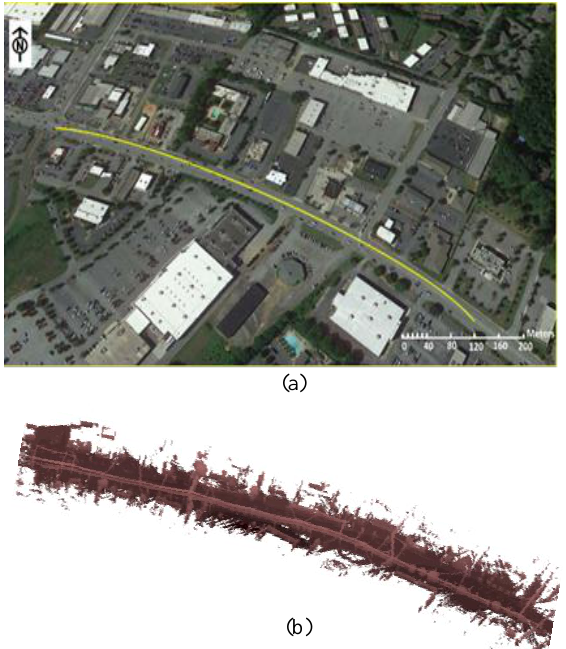
Figure 6. Study area: (a) Top view image of the study area; (b) Collected point clouds using the MTLS system.